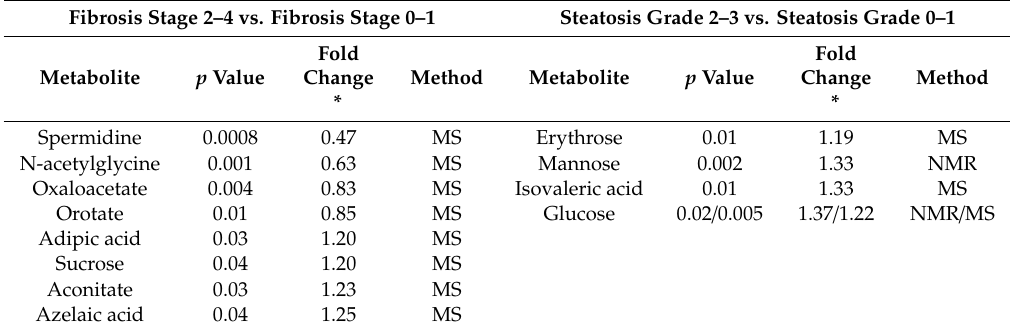
Table 3. Metabolites that di ff ered significantly between patients with di ff erent levels of hepatic fibrosis (F0-1 ( n = 43) vs. F2-4 ( n = 14) or steatosis (grade 0-1 ( n = 27) vs. grade 2-3 ( n =